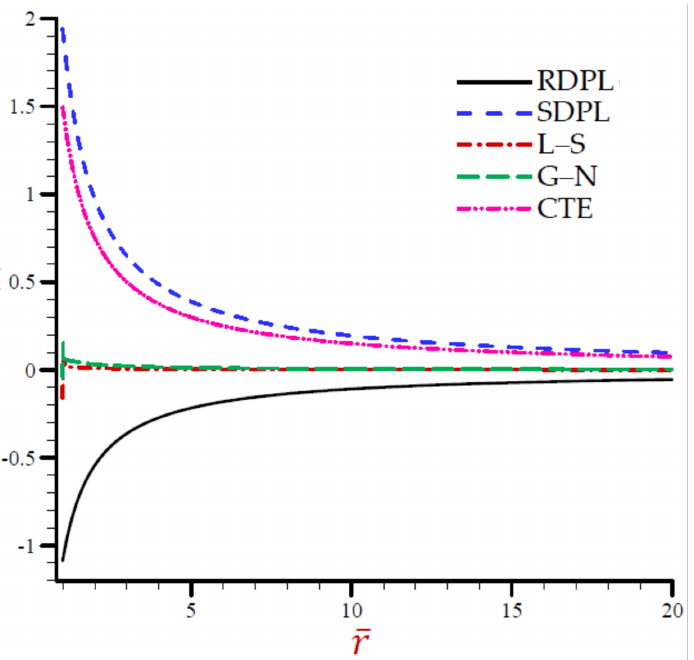
Figure 3. The radial displacement u across the radial direction of the cylindrical cavity conferring to all